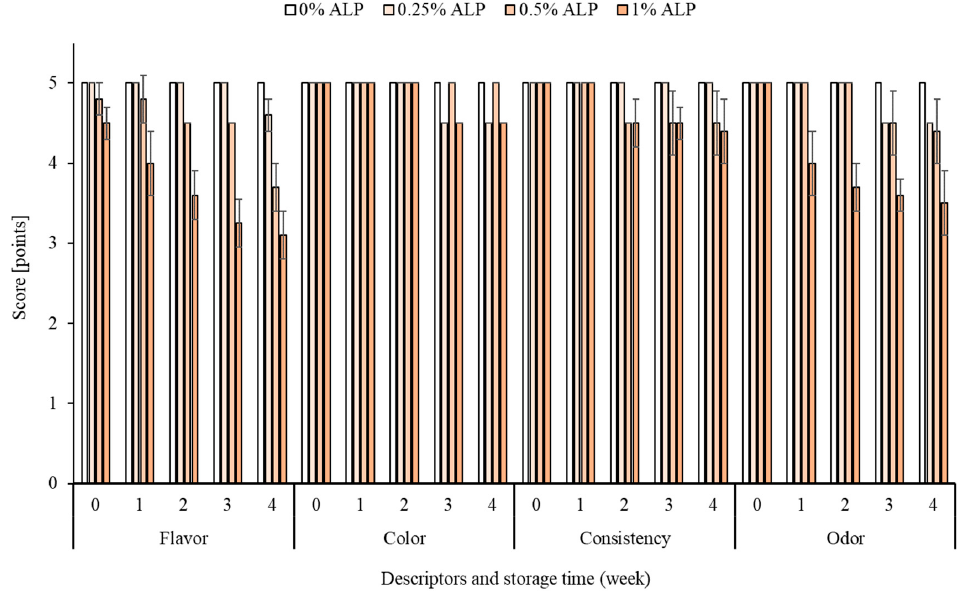
Figure 6. Sensory evaluation 4 descriptors of acid curd cheese with different addition (0–1%) of astaxanthin lipid preparation (ALP) during 4 weeks of refrigerated storage (5 ± 1 ◦